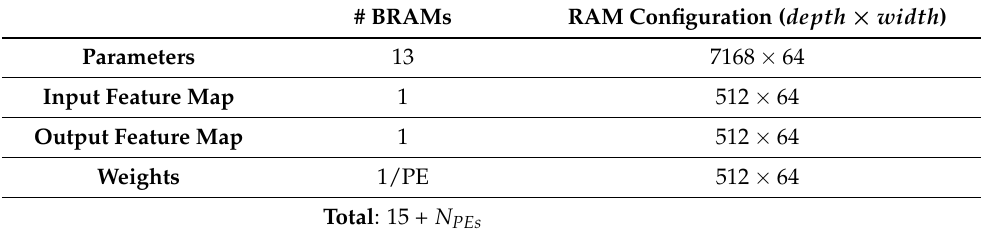
Table 8. RAM configurations summary.